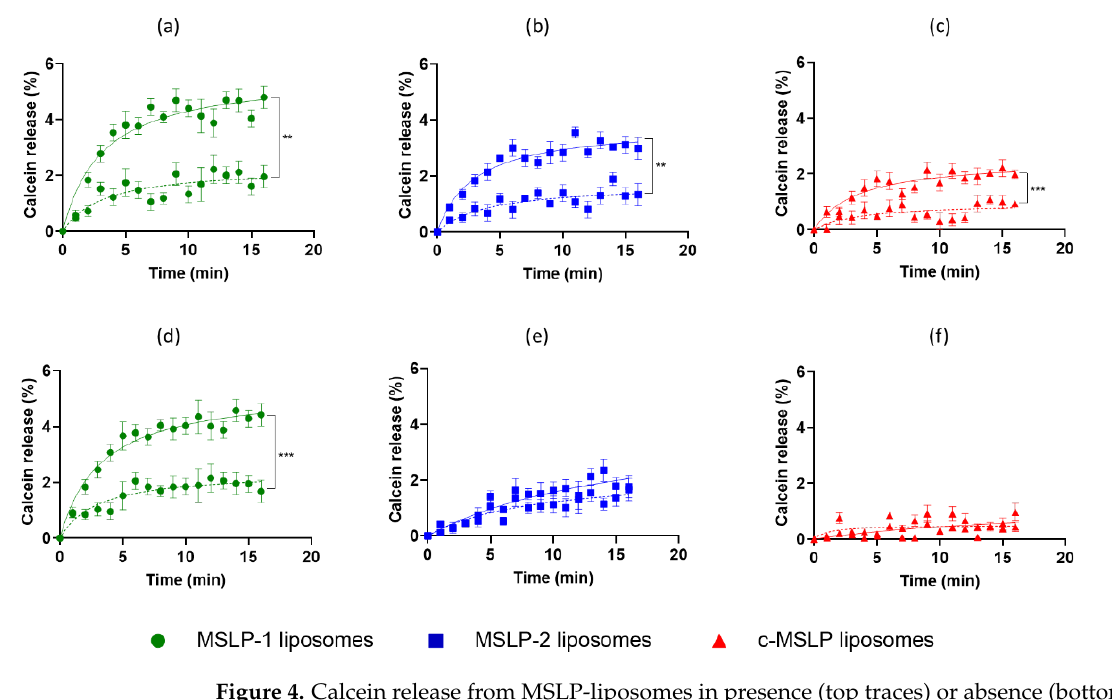
Figure 4. Calcein release from MSLP-liposomes in presence (top traces) or absence (bottom traces) of either activated MMP2 ( a – c ) or MMP9 ( d – f ). All data were subtracted of calcein release values from calcein-loaded chol/Sm/DSPE-PEG2000mal-liposomes. Results are expressed as mean ± SD. ** p < 0.01, *** p < 0.001 (Student’s t test). One-way ANOVA found a significant effect of treatment